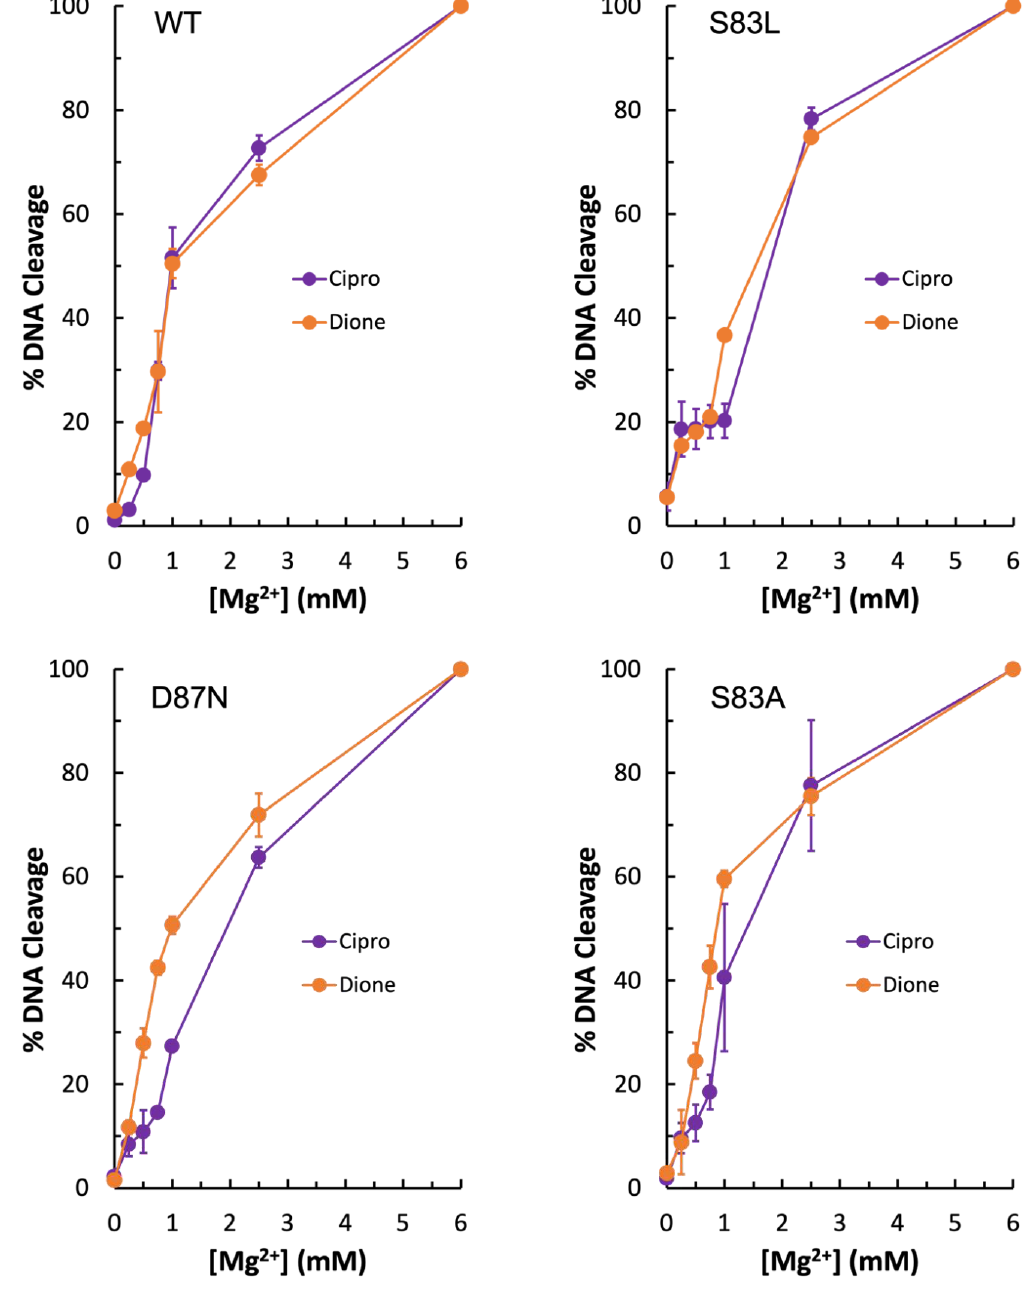
Figure 5. Levels of Mg 2+ required for wild-type and mutant gyrase enzymes to induce plasmid DNA cleavage in the presence of 50 µM ciprofloxacin (purple) or quinazolinedione (orange). Wild-type is shown in the top left, GyrA S83L in the top right, GyrA D87N in the bottom left, and GyrA S83A in the bottom right. Error bars represent the standard deviation of either two (WT, S83L, and D87N) or three (S83A) independent experiments.